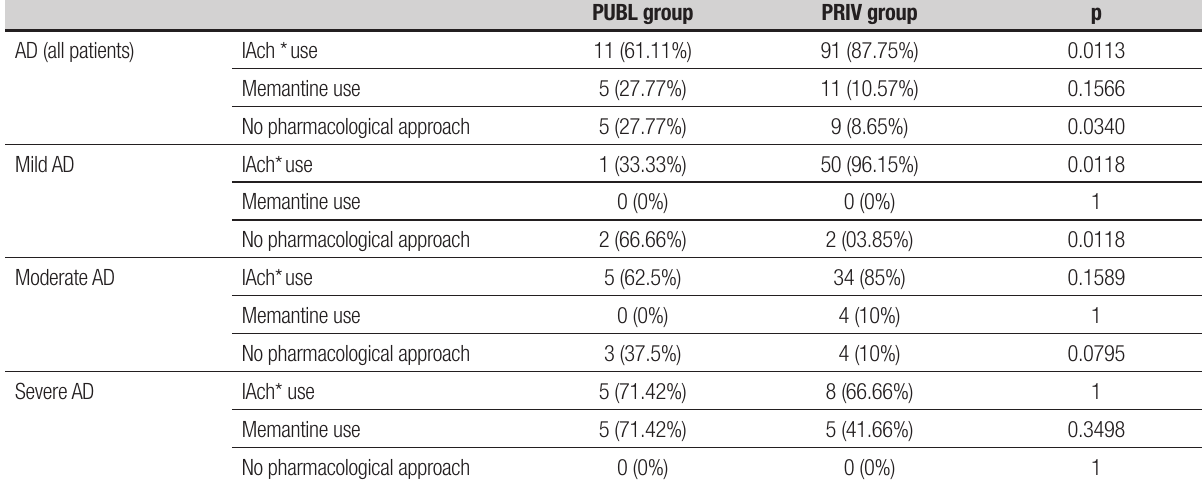
Table 5. Pharmacological therapeutic approach in mild, moderate and severe Alzheimer’s disease (AD), by number of patients.